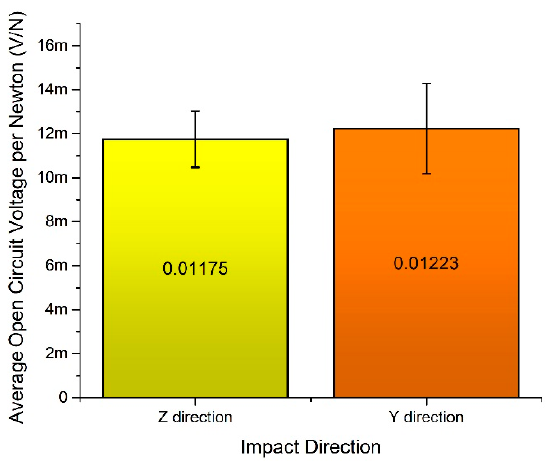
Figure 19. An average open circuit voltage per 1 N. Sensors 2019 , 19 , x FOR PEER REVIEW